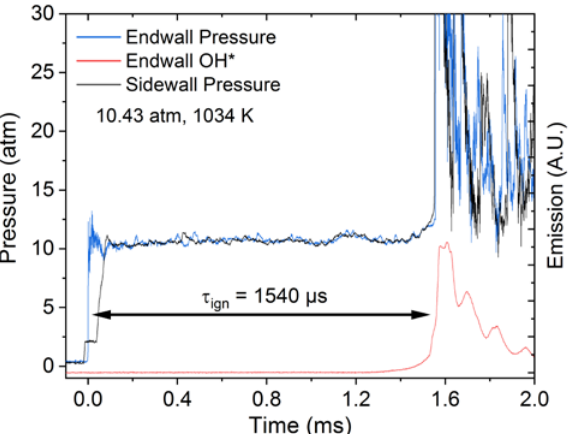
Figure 1. Representative pressure and OH* emission time histories for an experiment at stoichiometric conditions for isopropanol combustion in real fuel–air. Here, τ ign is defined as the difference between shock reflection at the endwall and the steepest initial rise in OH* signal at the endwall.